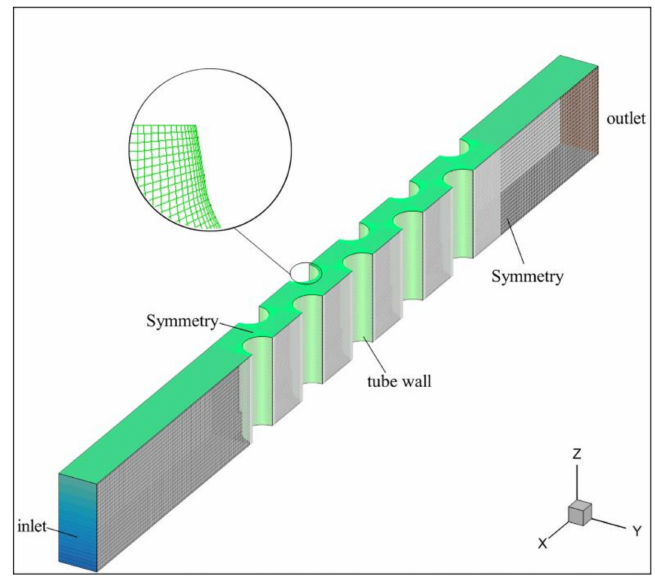
Figure 10. Grid division and local encryption.